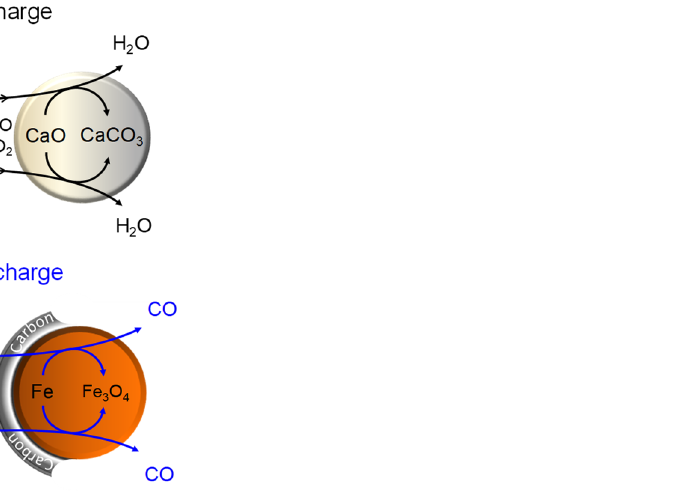
Figure 17. Space-time yield vs. time-on-stream for combined CO 2 capture and Fe 3 O 4 reduction over a NiO/Fe 2 O 3 -CeO 2 and CaO-Al 2 O 3 (1:5) mix. ( a ) CaO carbonation and Fe 3 O 4 reduction with CH 4 + CO 2 (1:1) at 650 °C, and ( b ) CaCO 3 decarbonation and CO production by iron and carbon oxidation by CO 2 . Temperature rise from 650 to 720 °C in He. Solid line: temperature profile [84]. Initially, CO 2 decreases because it gets adsorbed by CaO and consumed in dry re- forming. Once CaO is fully loaded with CO 2 , the CO 2 space-time yield increases again to